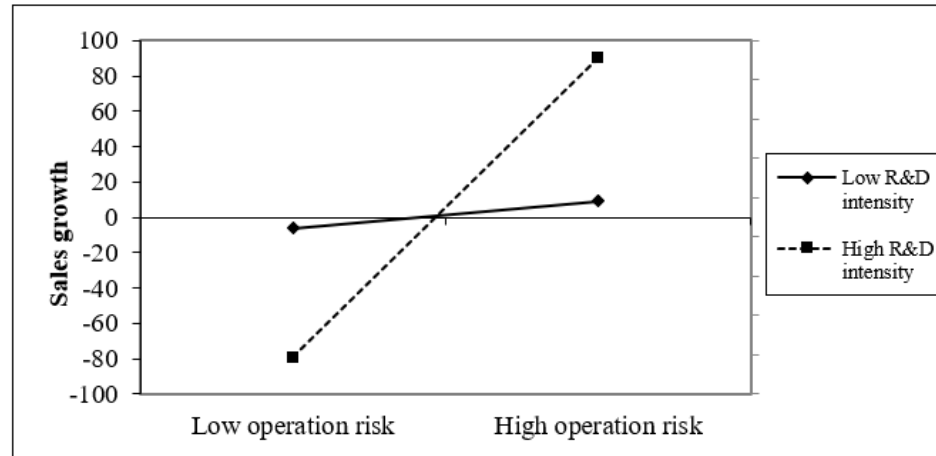
Figure 2. Interaction effect of operating risk and R&D intensity.